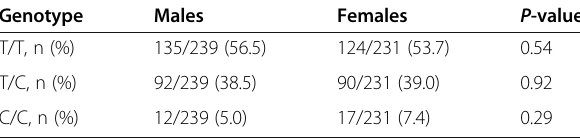
Table 3 Distribution of the three genotypes of rs1478604 in